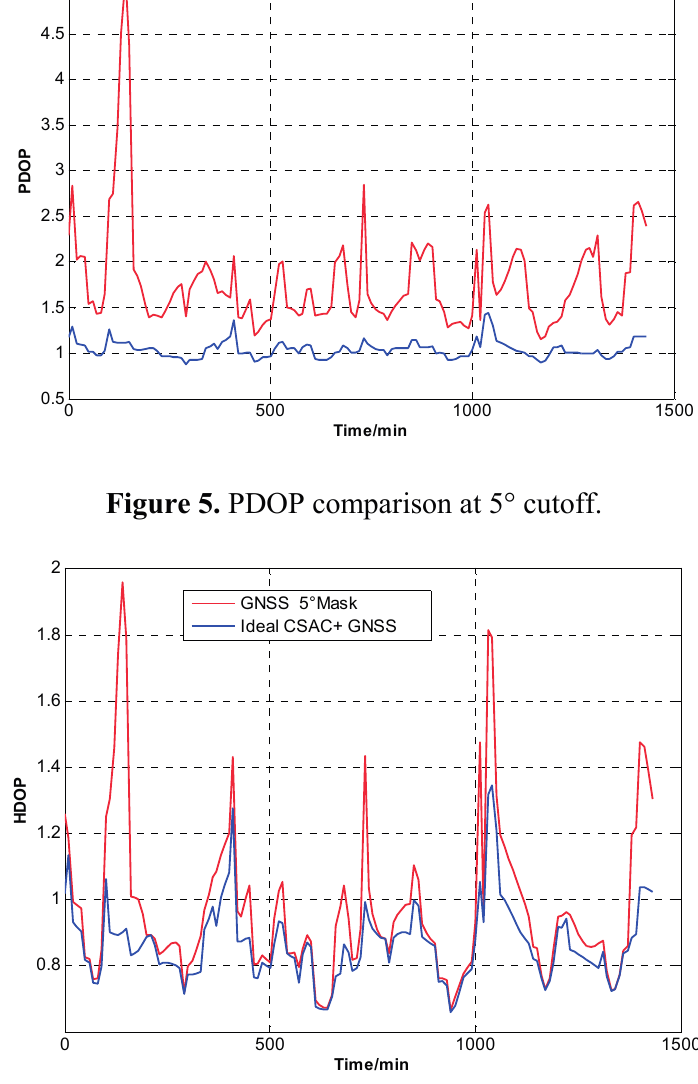
Figure 6. HDOP comparison at 5°